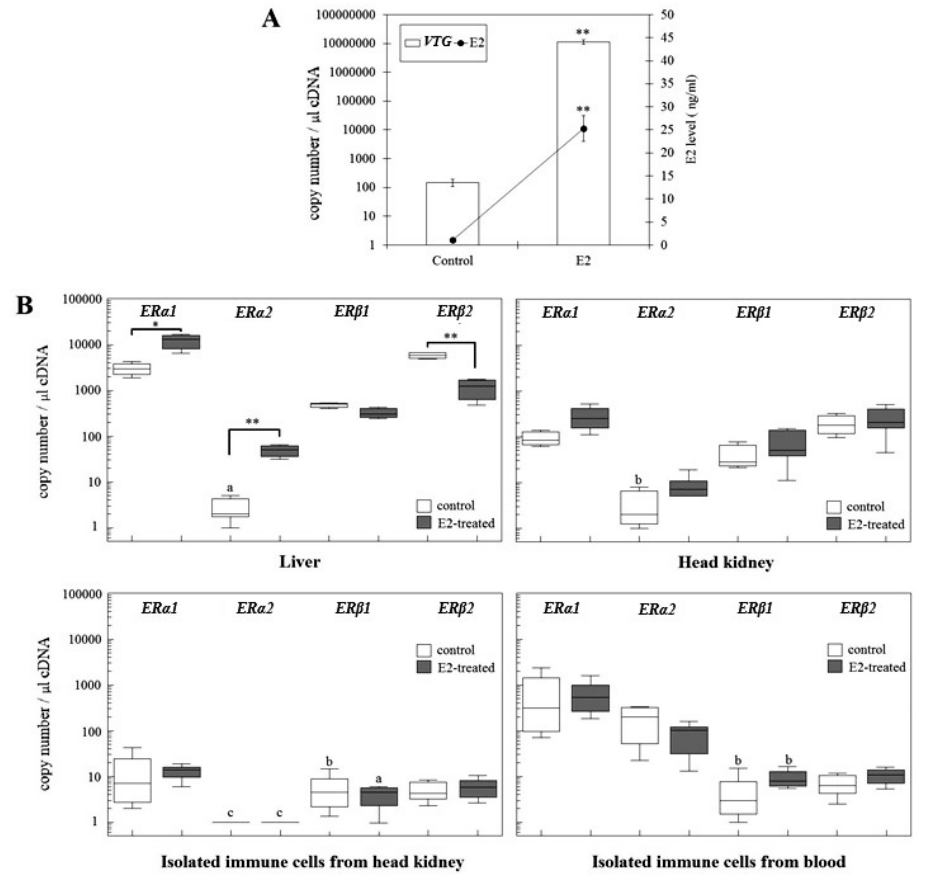
Figure 2. Response to exogenous 17 β -estradiol treatment in 6-month-old juvenile female trout. Fish were fed with E2 containing pellets for five days and pellets prepared with only vehicle (ethanol) were used as control diets. ( A ) Absolute quantification of vitellogenin (VTG) mRNA in the liver and E2 levels in serum of the control ( C ) and E2-treatment (E2) groups. The absolute VTG gene copy number per 1 µ L cDNA in the liver is shown as mean ± SE ( n = 5 individuals). ( B ) Absolute mRNA quantification of the four ER isoforms in liver, head kidney, immune cells isolated from head kidney and blood of 6-month-old rainbow trout treated with E2. The gene copy number of each isoform per 1 µ L cDNA is presented by Box-Whisker plots ( n = 5 individuals). Control and E2-treated group were compared for statistical analysis. The asterisks denote statistically significant differences between control and E2-treated groups. * p < 0.05, ** p < 0.01. a: under detection limit. b: Part of the sample was not detectable or under detection limit. c: not detected.